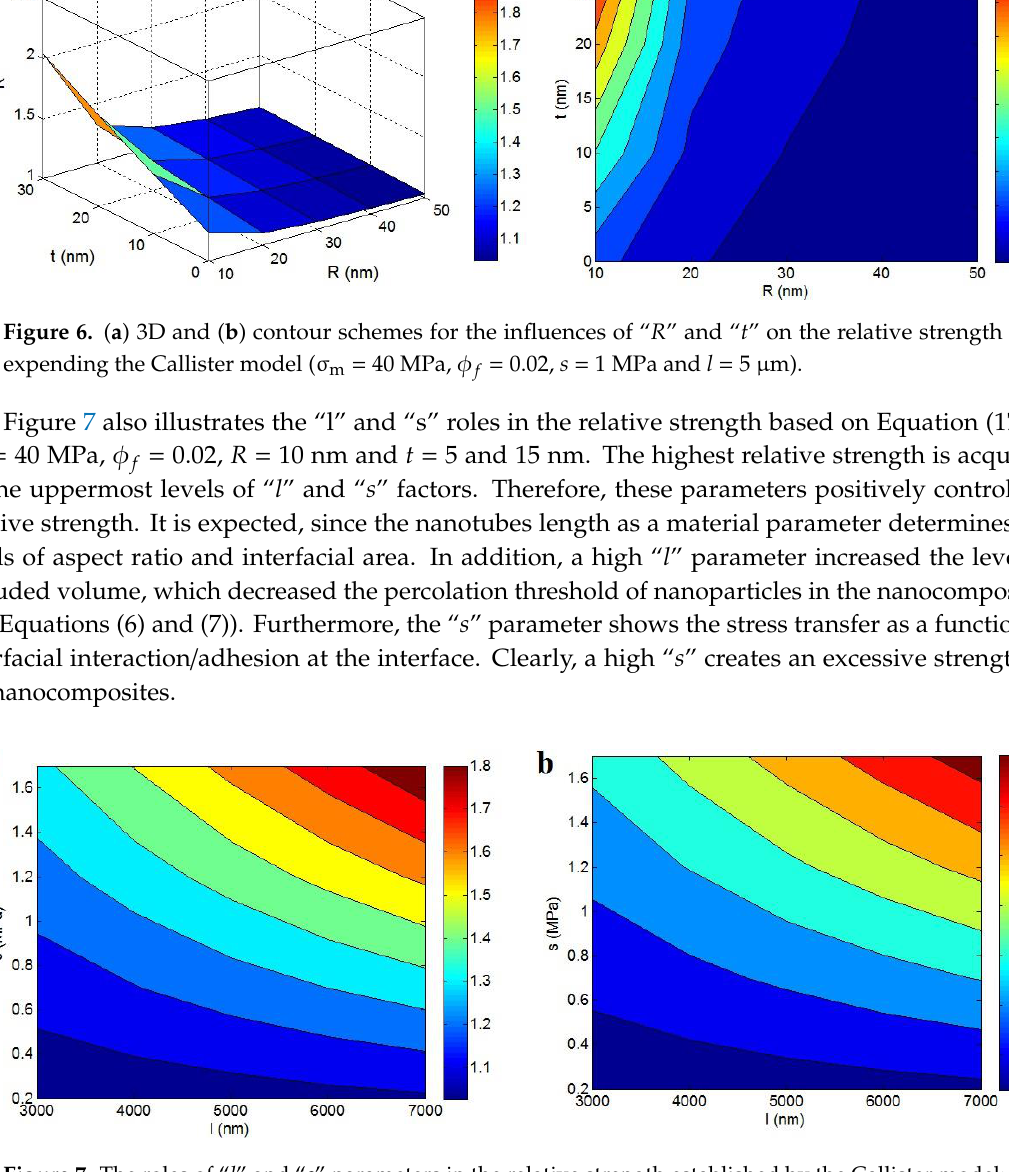
Figure 7. The roles of “ l ” and “ s ” parameters in the relative strength established by the Callister model: ( a ) t = 5 nm and ( b ) t = 15 nm.